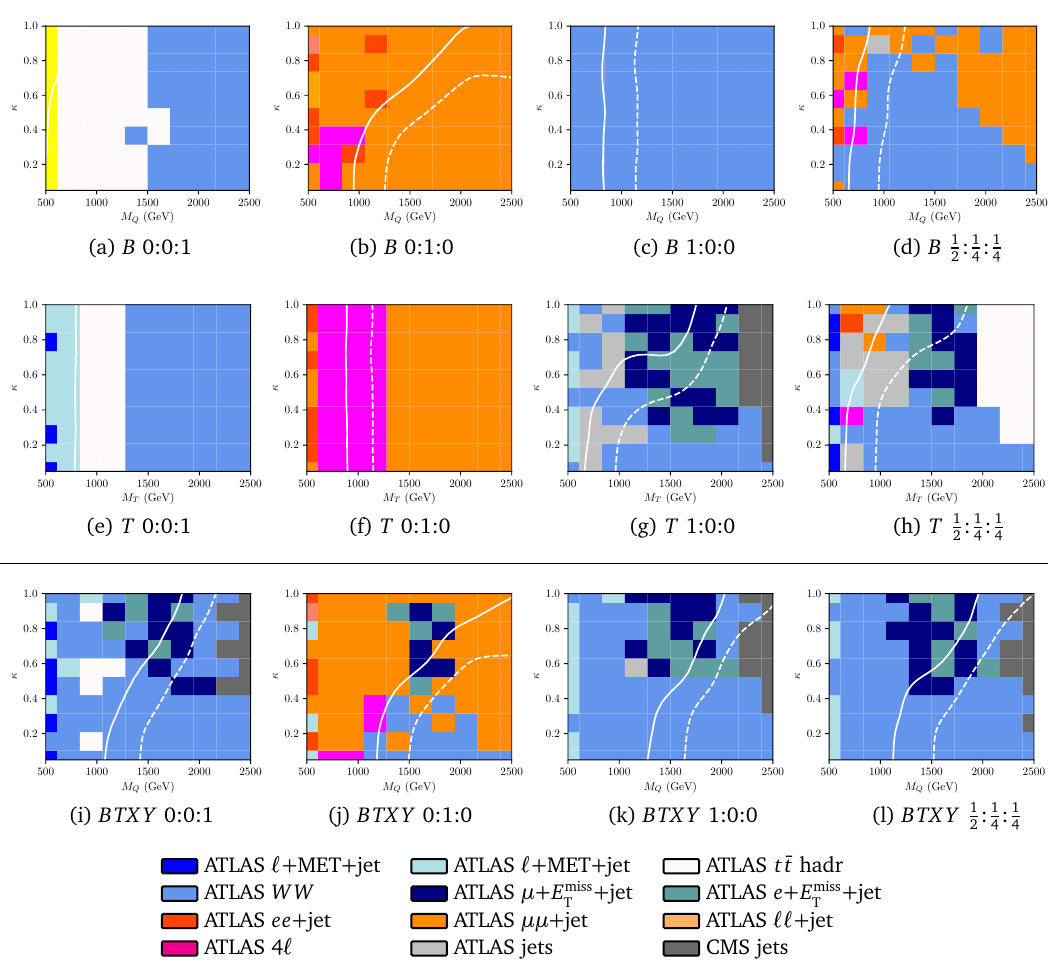
Figure 19: Sensitivity of LHC measurements to VLQ singlet production in the κ vs VLQ mass plane, where κ is the coupling to third-generation SM quarks. All VLQ masses are set to be degenerate. The multiplets are given as rows: (a)–(d) B singlet, (e)–(h) T singlet, and for comparison to the main text, the (i)–(l)( B , T , X , Y ) quadruplet. The VLQ branching fractions to W : Z : H are arranged in columns of 0:0:1, 0:1:0, 1:0:0, and 1 : 1 : 1 from left to 2 4 4